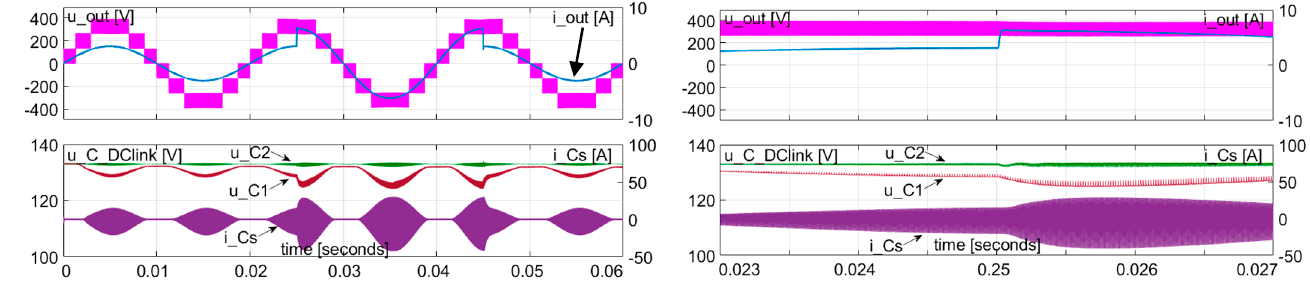
Figure 19. A step change of load ( P out ) from 0.5 kW to 1 kW at t = 25 ms and from 1 kW to 0.5 kW at t = 45 ms (the AIVB operates in constant switching frequency operation).